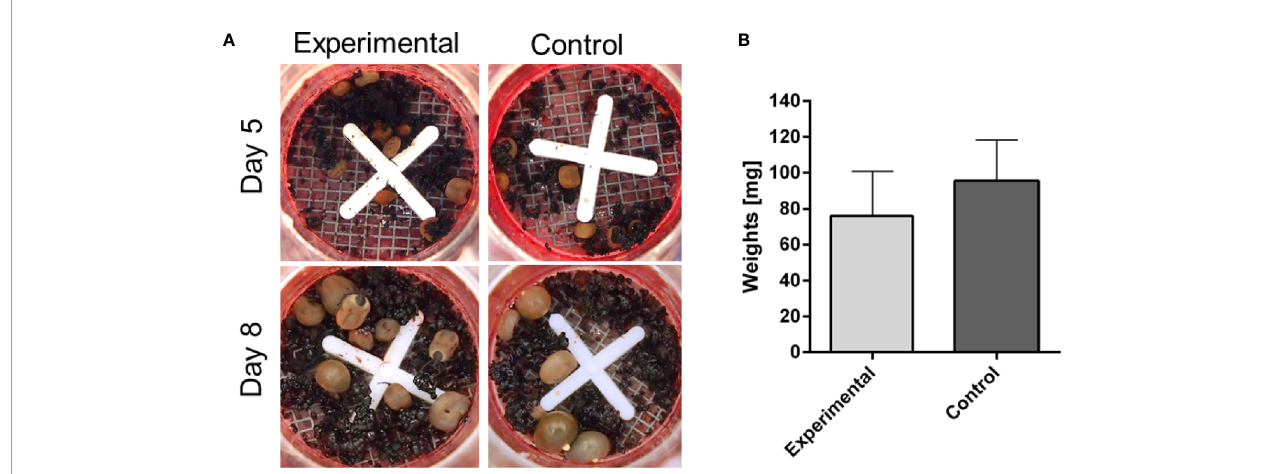
FIGURE 3 | Membrane feeding of Ixodes ricinus adults on blood from infested rabbit. I. ricinus adults were fed on reconstituted rabbit blood (haematocrit 60%) either from a previously infested rabbit, by repeated adult I. ricinus feeding (experimental), or from a naïve rabbit (control). (A) Pictures of feeding units during the course of arti fi cial feeding. (B) Weights of dropped-off females and females removed on Day 10. Bars represent a mean and SEM, n ≥